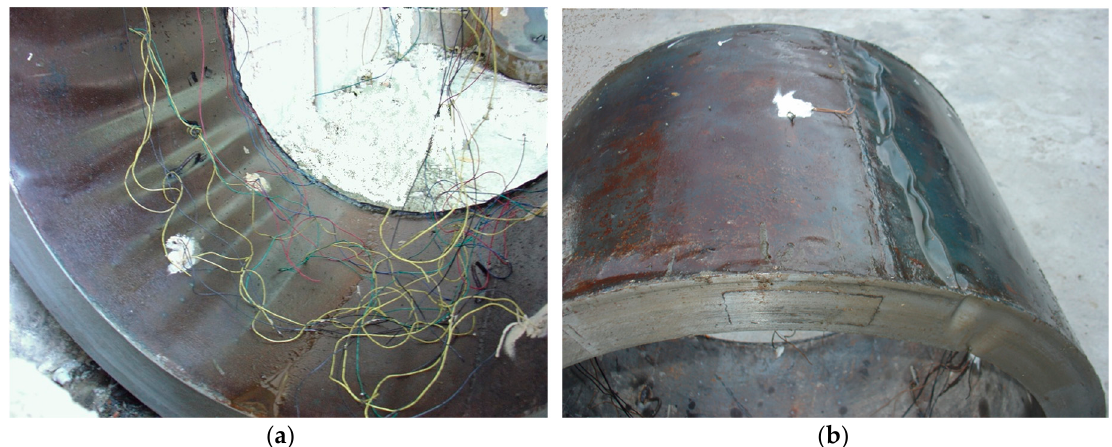
Figure 13. Failure form of the shaft lining model: ( a ) inner surface ( b ) outer surface.